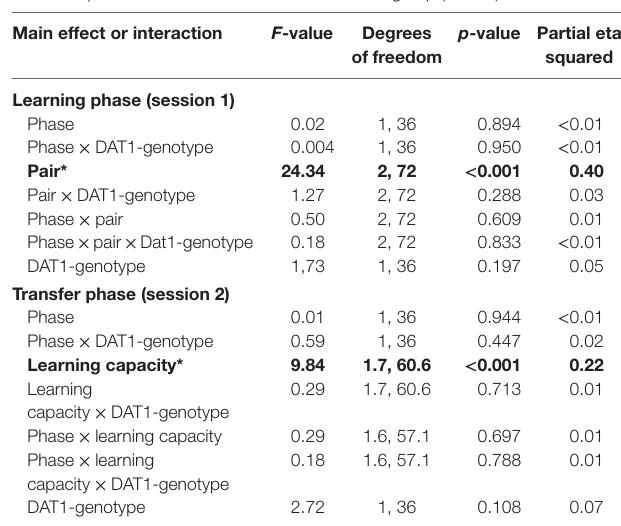
Table 3 | Main effects and interactions in the HC group ( n = 39).